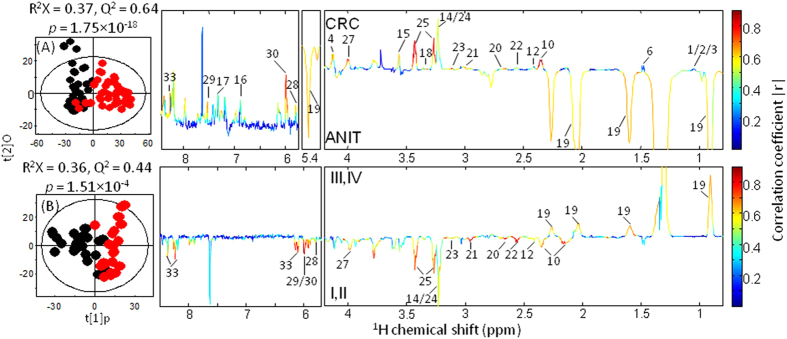
OPLS-DA scores (left) and coefficient-coded loadings plots (right) showing the discrimination between (A) ANIT () and CRC tumor () (n = 50, |r| > 0.29) and (B) stages I-II tumor () and stages III–IV tumor () (n = 22, |r| > 0.41). Metabolite keys are given in Fig. 1 and Table S1.